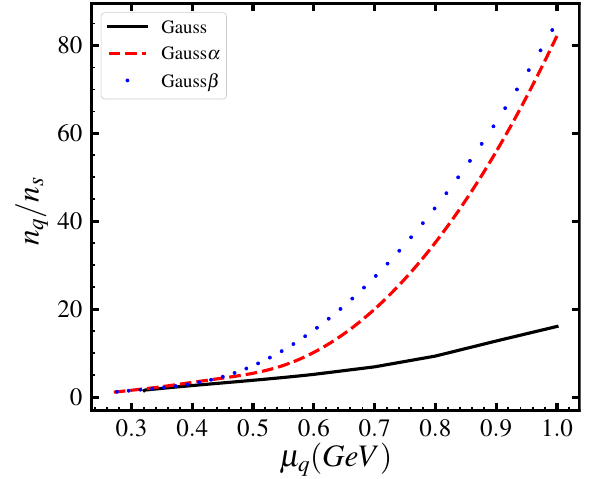
Fig. 5 Calculated number density (in unit of the saturation nuclear matter density n S ) of the u and d quarks as a function of quark chem- ical potential. The black solid line corresponds to the result using the Gaussian-type gluon model without modification, the red dashed line stands for the result by implementing the Gaussian-type gluon model with the α -type modification, and the blue dotted line represents the result with the β -type modification